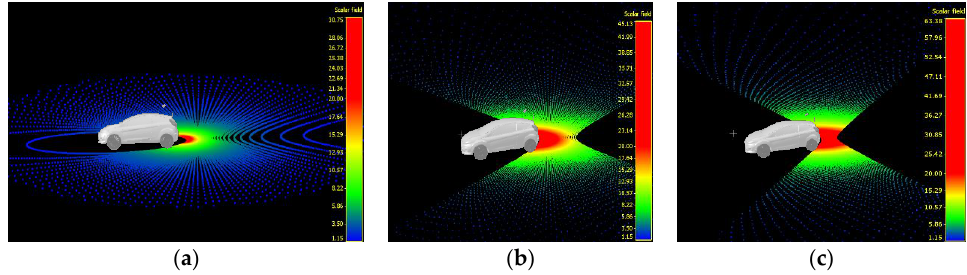
Figure 24. The relation between the OS-1-64 Lidar tilt angle and the incidence angle where red points having > 20 ◦ incidence angle on the ground. ( a ) @ 15 ◦ tilting angle: the average angle of incidence ≈ 12 ◦ ± 8 ◦ . ( b ) @ 30 ◦ tilting angle: the average angle of incidence ≈ 20 ◦ ± 11 ◦ . ( c ) @ 50 ◦ tilting angle: the average angle of incidence ≈ 30 ◦ ± 16 ◦ .